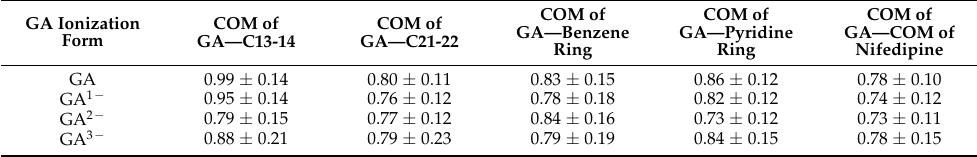
Figure 7. Moieties of a nifedipine molecule, which were used to measure distances from C13, C14 and C21, C22 carbon atoms of methyl groups, the pyridine ring and benzene ring are highlighted by magenta, red, green, and blue, respectively. Table 2. Distances (nm) between different groups of the nifedipine molecule and the center of mass (COM) of GA ions obtained from Figure 4, averaged over the last 100 ns of simulation